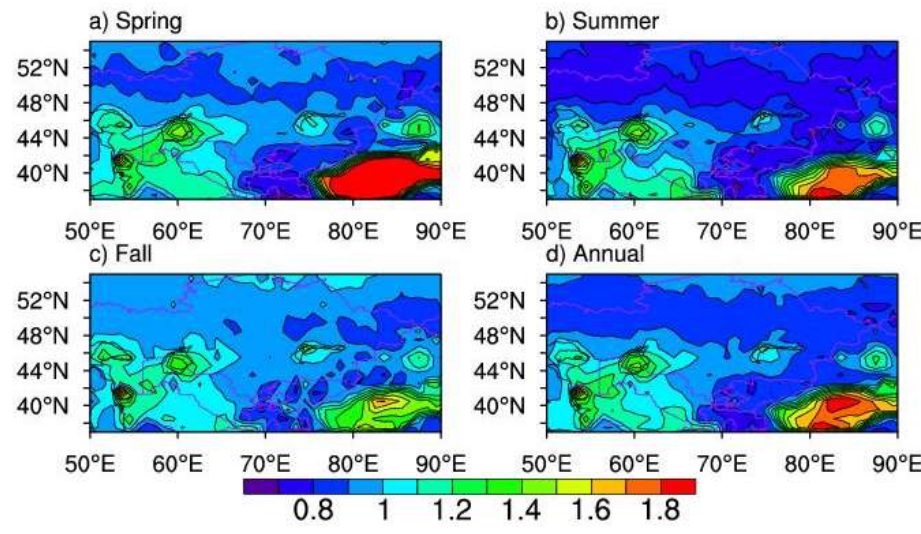
Figure 5. Seasonal mean of AAI for 2003–2007: ( a – d ) spring, summer, fall, and the averaging of these three seasons, respectively.